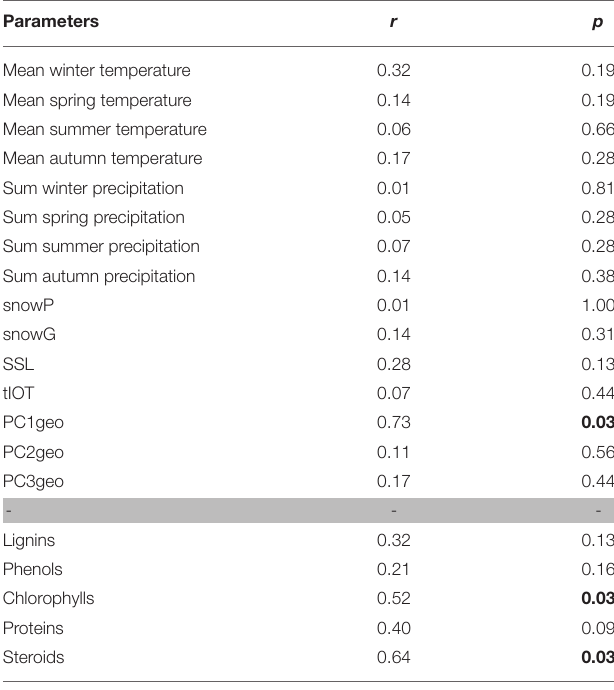
TABLE 2 | Correlations between the community structure and environmental parameters calculated using the env.fit function.